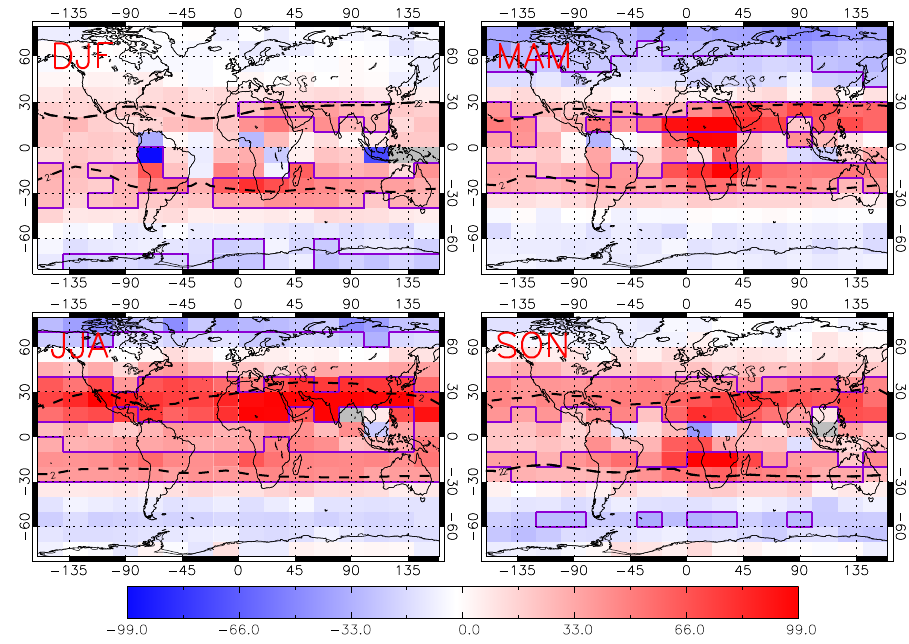
Figure 4. Difference in MIPAS PAN (pptv) from IMK retrieval minus UoL retrieval at 150hPa for 2007–2008 in DJF, MAM, JJA, and SON. Purple polygon regions show regions of significant differences, where the IMK and UoL retrieval uncertainty ranges do not overlap.